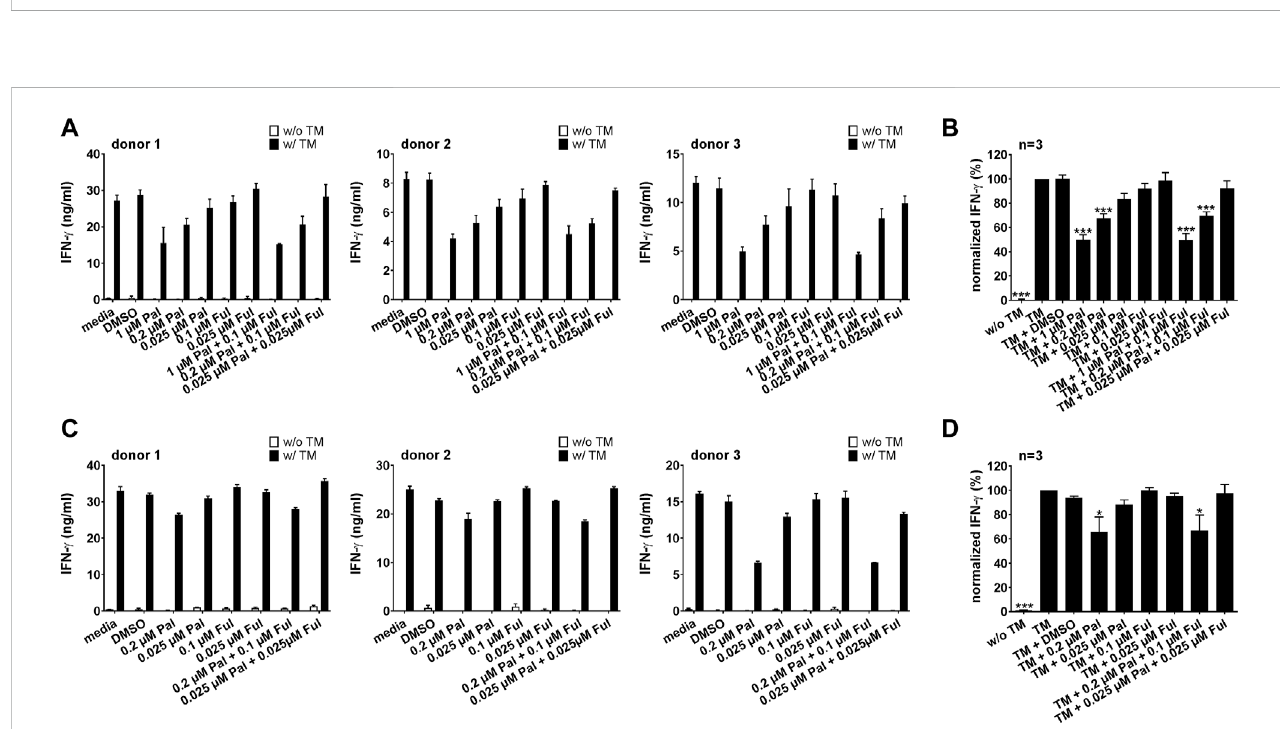
FIGURE 6 Effect of palbociclib and fulvestrant on IFN- γ release of TM-engaged UniCAR T cells. UniCAR T cells and (A,B) PC3-PSCA/PSMA Luc+ or (C,D) LNCaP- PSCA Luc+ cells were incubated with or without 30 nM of PSCA TM in the presence or absence of palbociclib and/or fulvestrant. After 96 h, IFN- γ concentrations in co-culture supernatants were analyzed by ELISA. (A,C) Each diagram shows average IFN- γ concentration ± SEM of triplicates for one T cell donor, respectively. (B,D) Graphs summarize relative IFN- γ release ± SEM of three different T cell donors. IFN- γ concentrations in the presence of UniCAR T cells, tumor cells and TM ( “ TM ” ) were equalized to 100%. (* p ≤ 0.05, ** p ≤ 0.01, *** p ≤ 0.001 compared to control sample “ TM ” ; One-way ANOVA with posthoc Dunnett multiple comparison test).